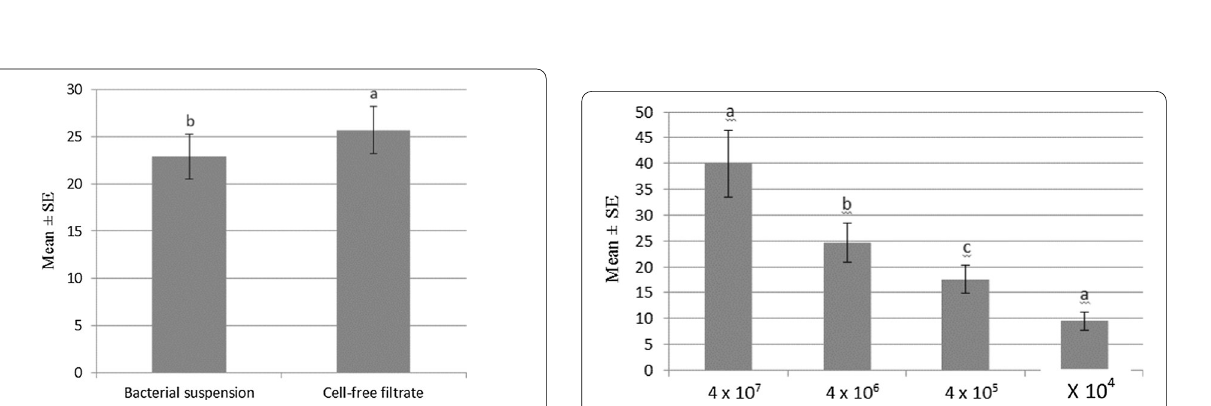
Fig. 2 Mortality of Locusta migratoria migratorioides after treatment with 4 different densities of Photorhabdus luminescens (EGAP3). Bars (mean SE in the same and between time intervals with the same ± letter(s) are not significantly different ( P <